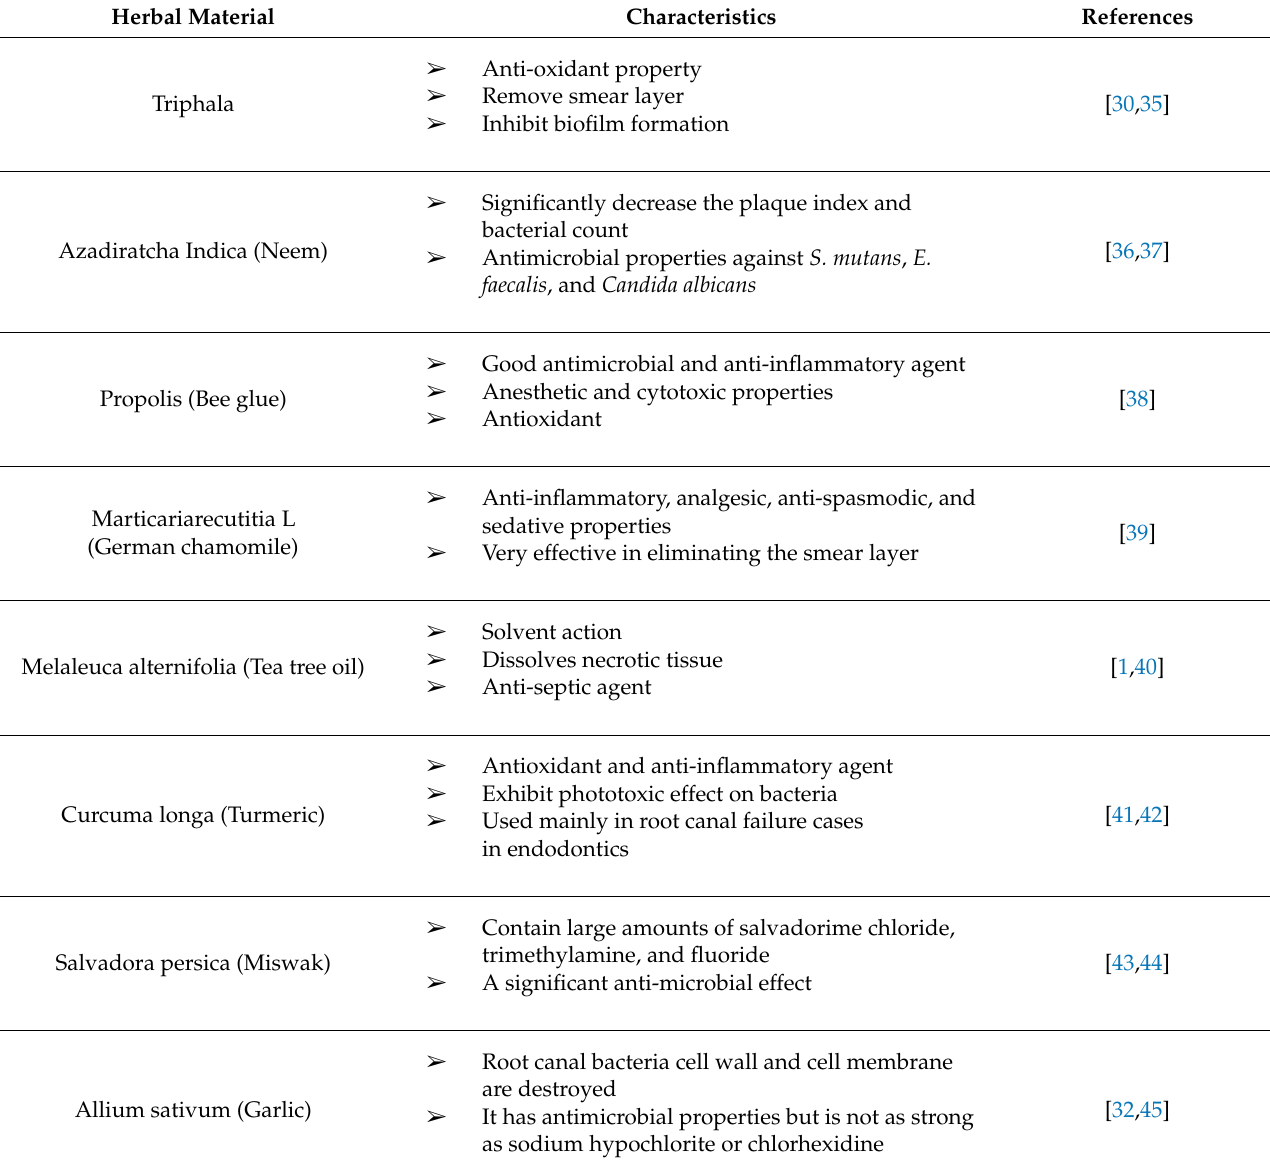
Table 3. Studies related to the use of herbal medicine for cleaning and disinfecting root canals.